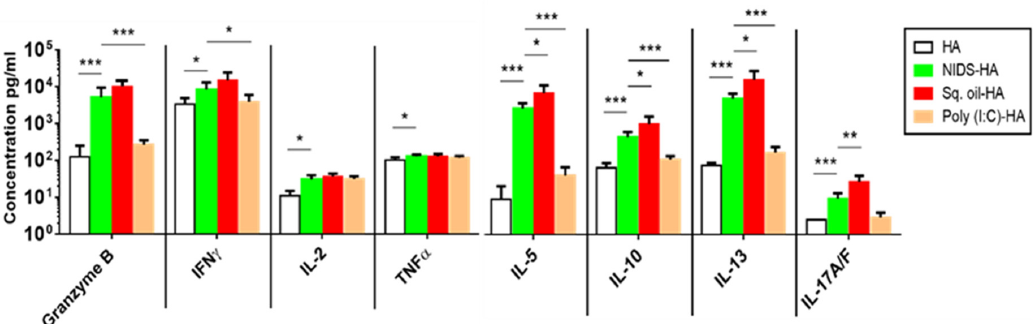
Figure 3. Cellular responses in spleen following two intramuscular vaccinations with NIDS compared to HA alone or other adjuvants. Groups of five mice each were vaccinated as described under the Figure 2 legend. Single cell suspensions were prepared from spleens. Adaptive T Helper 1 (TH1), TH2, TH17, and Treg cytokine responses were measured in splenocyte (5 × 10 6 ) supernatants following activation for 72 h with HA. Assays used were ELISA (IL ‐ 17) or multiplex Luminex (all other cytokines). Granzyme B, IFN γ , TNF α , IL ‐ 2, IL ‐ 5, IL ‐ 13, IL ‐ 10, and IL ‐ 17A/F. The data are presented as mean values from five mice per group ± SEM (error bars). Statistical significance is represented as * p ≤ 0.05, ** p < 0.01 and *** p < 0.001. One representative study of three with similar results is shown.